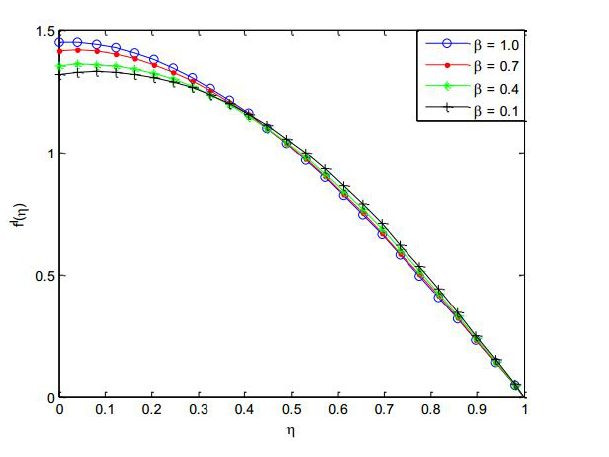
Figure 8. Effects of Casson fluid parameter on the